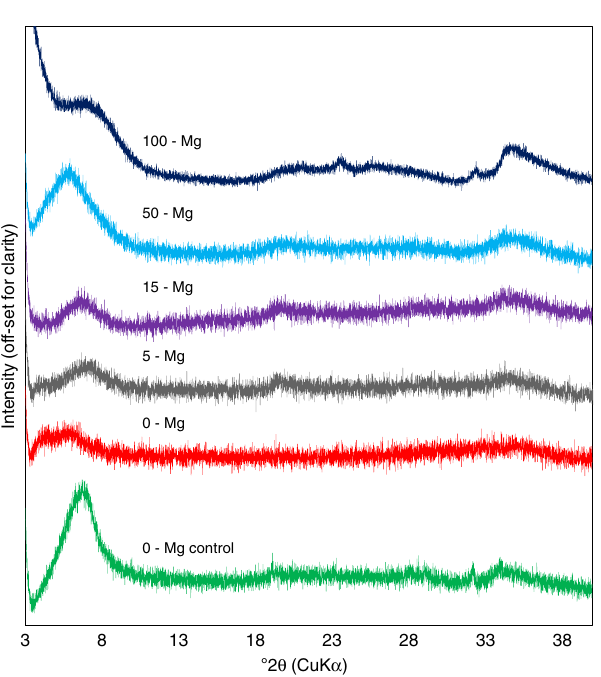
Fig. 1 X-Ray diffractograms of the synthetic clay minerals. Samples were analyzed as oriented samples on Si-mounts. Note that the 001 diffraction of the 0-Mg nontronite control, using initial Fe 2+ , indicates that the control is crystalline, whereas the 0-Mg experiment, including only Fe 3+ is largely amorphous. This is also shown in the 100 °C experiments (Supplementary Fig. 21) and is in agreement with the previous studies of Harder 7 , and Decarreau et al. 8 . Increasing Mg concentrations in the Fe 3+ solutions resulted in increased crystallinity of the synthesized products. These results indicate that Fe-rich clay minerals can be precipitated under oxidized conditions, as long as Mg is present in at least small concentrations in the intial starting solution. The pure Mg precipitate had a much broader basal re fl ection, suggesting less coherent stacking along the